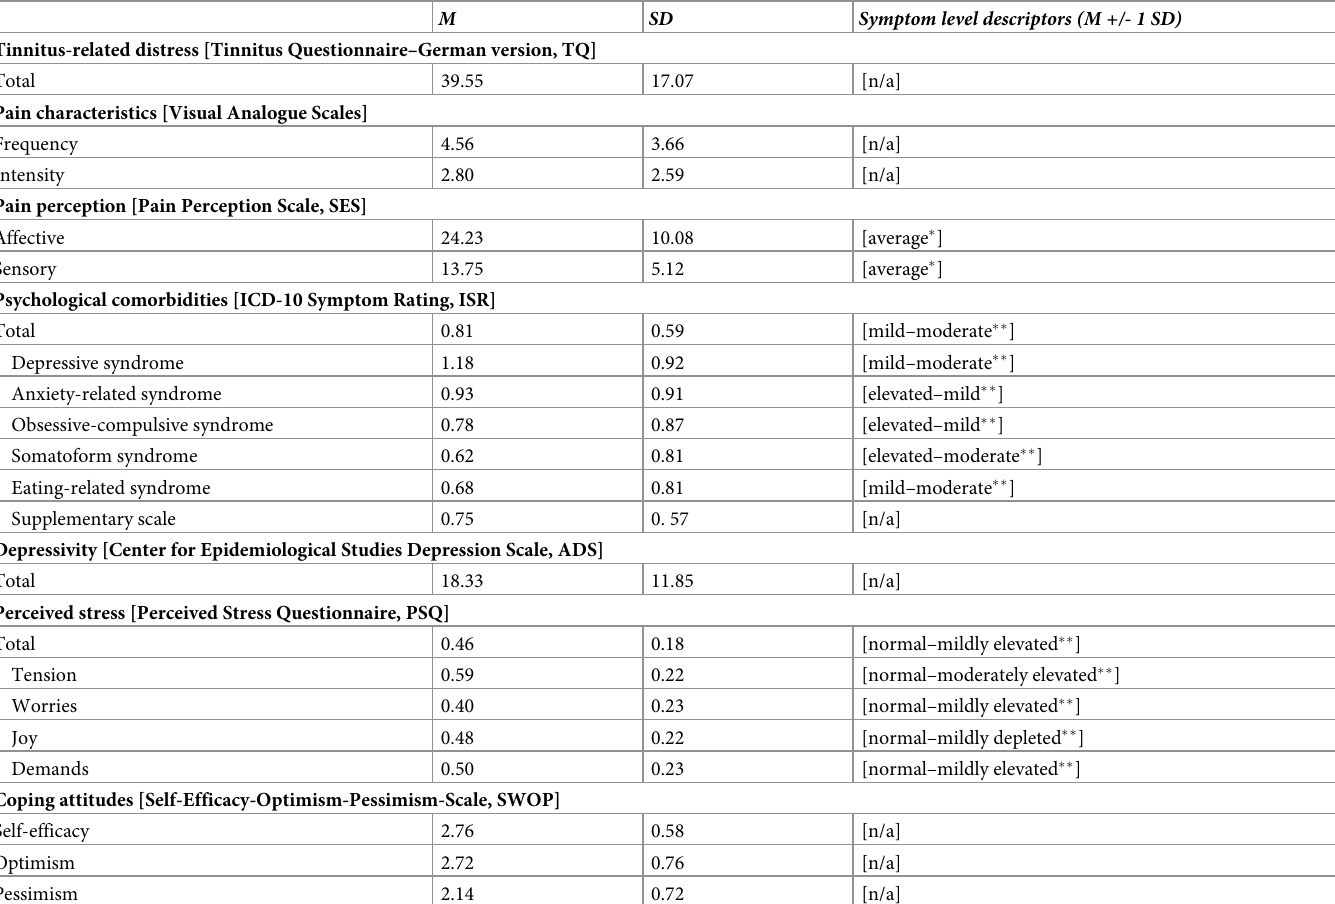
Table 2. Means, standard deviations and symptom level descriptors for the total sample ( N = 1238 patients with chronic tinnitus). M